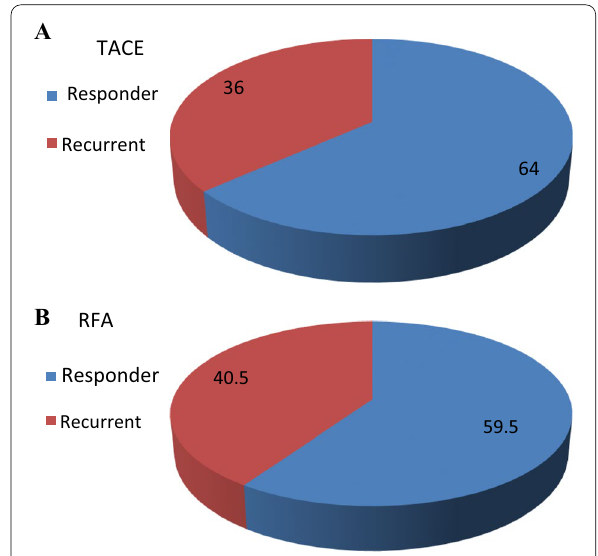
Fig. 1 Frequency of responders to TACE ( A ) and RFA ( B )